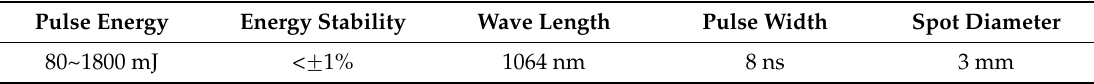
Table 1. Main parameters of INNOLAS Spitlight 2000 Nd-YAG